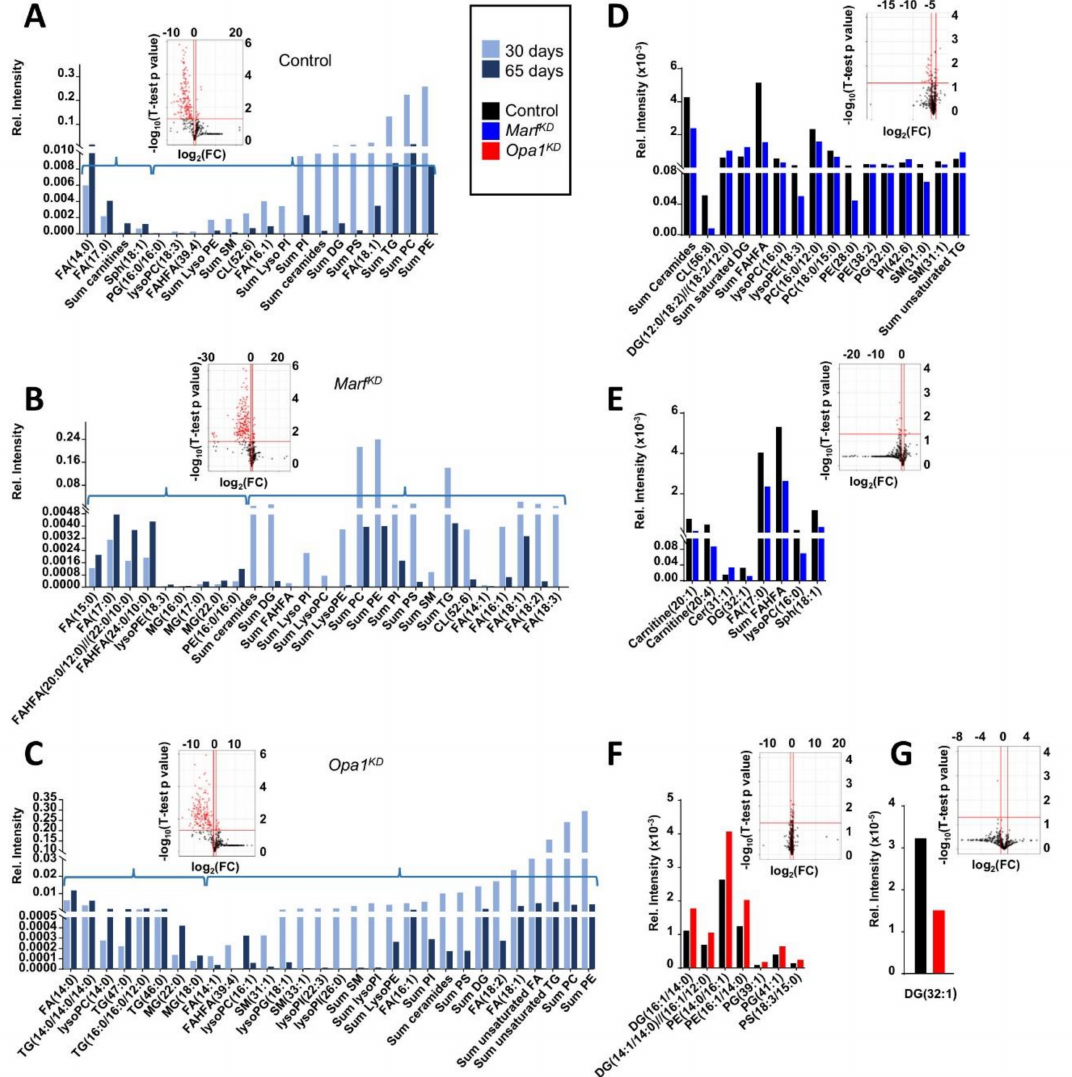
Figure 6. Analysis of head lipids in control, Marf KD and Opa1 KD flies at 30 and 65 days of age. Volcano plots were built to identify those lipids for which the analytical response changed significantly between the two conditions under comparison (FC < 2, p value t -test < 0.01). The corresponding bar diagrams compare the abundance of the relevant lipids. In order to facilitate the data interpretation, some lipids belonging to the same species were summed as long as they vary the same way. ( A ) Control 30 vs. 65 days. ( B ) Marf KD 30 vs. 65 days. ( C ) Opa1 KD 30 vs. 65 days. ( D ) Control vs. Marf KD at 30 days. ( E ) Control vs. Marf KD at 65 days. ( F ) Control vs. Opa1 KD at 30 days. ( G ) Control vs. Opa1 KD at 65 days. In A – C , brackets are used to group the lipids that increase (left) or decrease (right) with